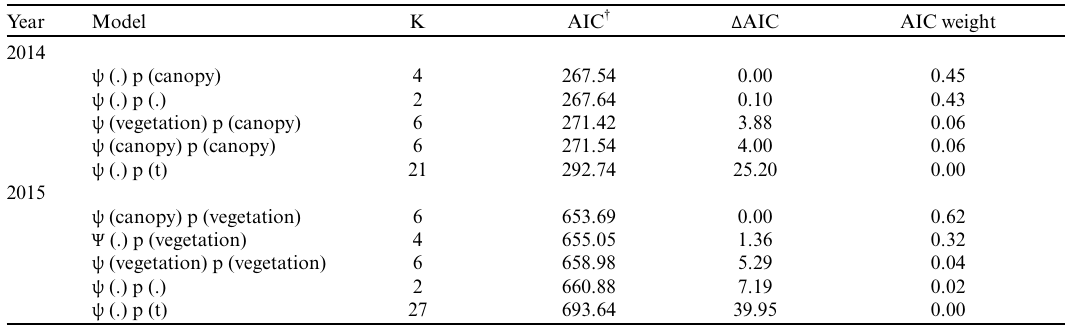
Table 2 . Occupancy ( ψ ) and detection (p) model selection results for Kori Bustard ( Ardeotis kori ) in the Northern Tuli Game Reserve, Botswana during June–July 2014 and May–July 2015. Each year was considered separately. K represents number of parameters. Δ AIC represents difference between model and best-fitting model (model with lowest AIC).